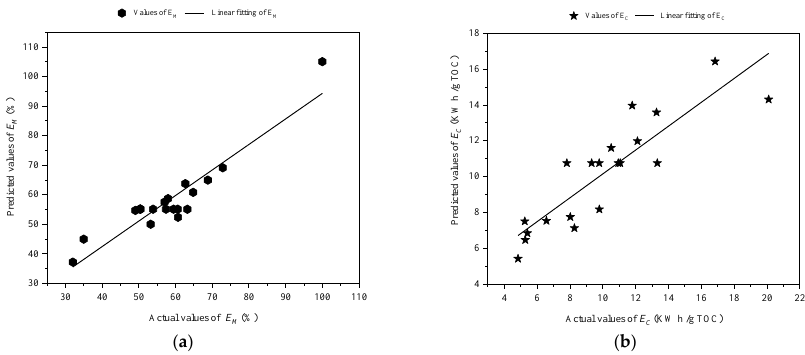
Figure 2. ( a ) Predicted versus experimental values plot for E M and ( b ) Predicted versus experimental values plot for E C .